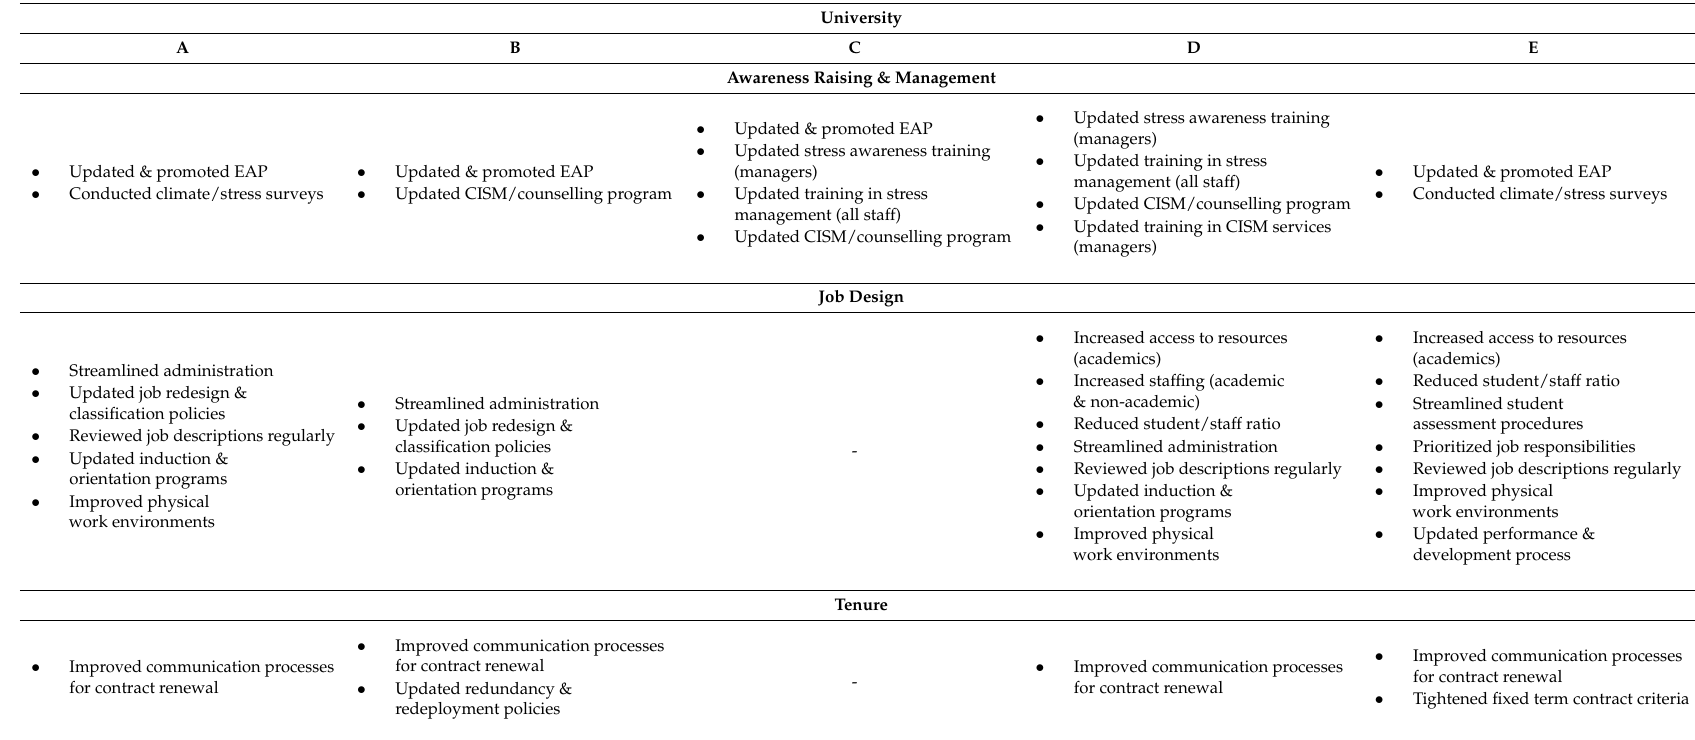
Table 3. Interventions to Manage Stress, Enhance Job Design, and Address Tenure